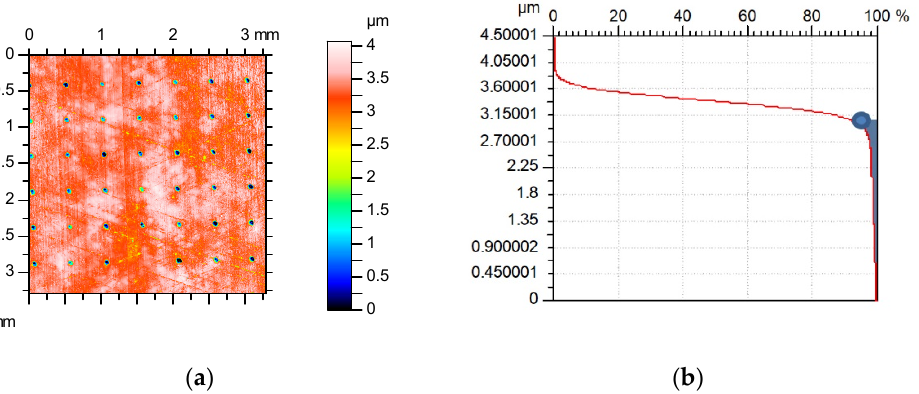
Figure 16. Contour plot of the textured cylinder surface ( a ), its material ratio curve with transition point, and oil capacity ( b ).